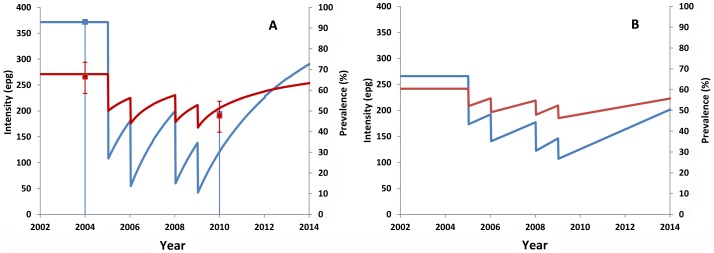
Comparison of the observed S. mansoni prevalence and intensity with the predicted changes in Macina.Prevalence is shown in red and intensity of infection is shown in blue. S. mansoni infection is shown in 7–14 year group (A) and in entire population (B). Lines show the predicted changes and squares in A show the observed results. Error bars represent the 95% CI.